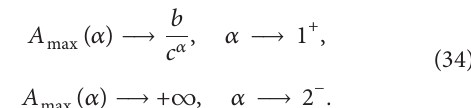
Figure 5: Curves of 𝐴 versus 𝛼 for 𝑏 = 1 and 𝑐 = 1 and for 𝜆 = 0.5 (solid line), 𝜆 = 1 (dashed line), 𝜆 = 1.5 (doted line), and 𝜆 = 2 (doted-dashed line).